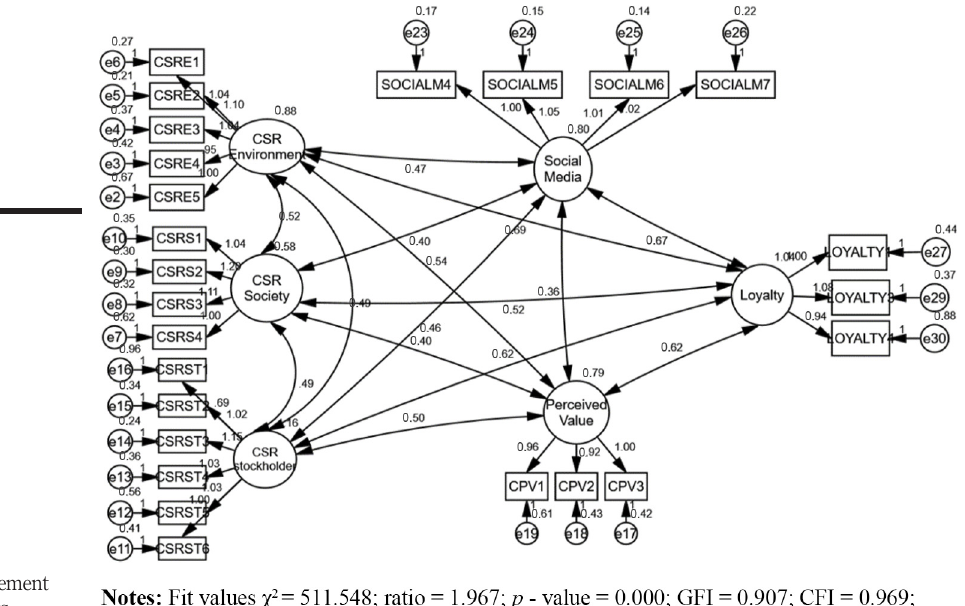
Figure 2. The measurement model